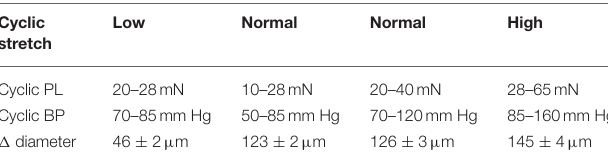
TABLE 1 | Preloads (PL) and corresponding transmural pressures